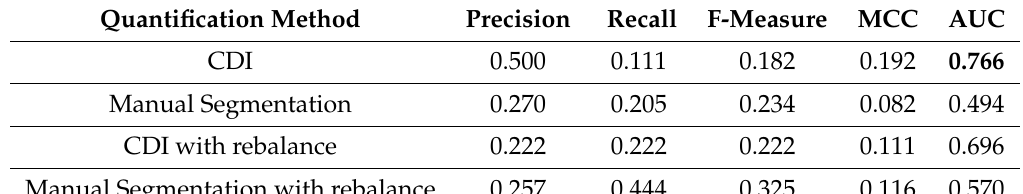
Table 4. Prediction performance of ANN using center CDI locations and manual segmentation on X2 slice.